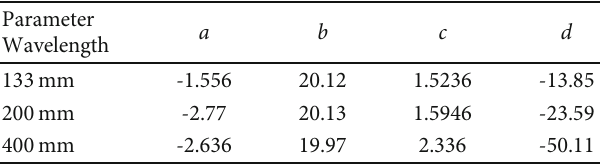
Table 8: y -direction force parameter values of the dorsal fi n at di ff erent